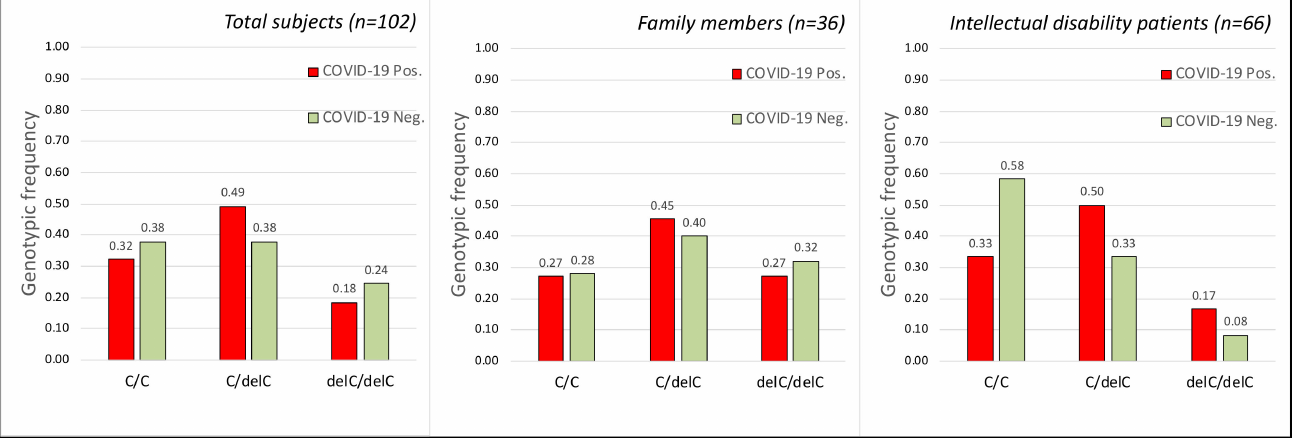
Figure 1. Frequency of the three genotypes obtained by the C and delC alleles of the rs35074065 SNP polymorphism (TMPRSS2 gene) in the analyzed groups. ( Left ) Genotype frequency in the total subjects (Chi-square Test for 3 2: Chi = 0.019 p = 0.991 df = 2; Sample size = 102; power = × 0.132740). ( Middle ) Genotype frequency in the subjects belonging to the analyzed families with cohabiting members (Chi-square Test for 3 2: Chi = 0.1119 p = 0.9456 df = 2). ( Right ) Genotype × frequency in the subjects belonging to the intellectual disability patients cohabiting in the Oasi M. Santissima IRCCS (Troina, Italy) (Chi-square Test for 3 2: Chi = 2.65 p = 0.265 df = 2). Each group × was subdivided into infected (COVID-19 Pos.) and non-infected (COVID-19 Neg.) groups. No statistically significant correlation was obtained between SARS-CoV-2 infection and the rs35074065 SNP